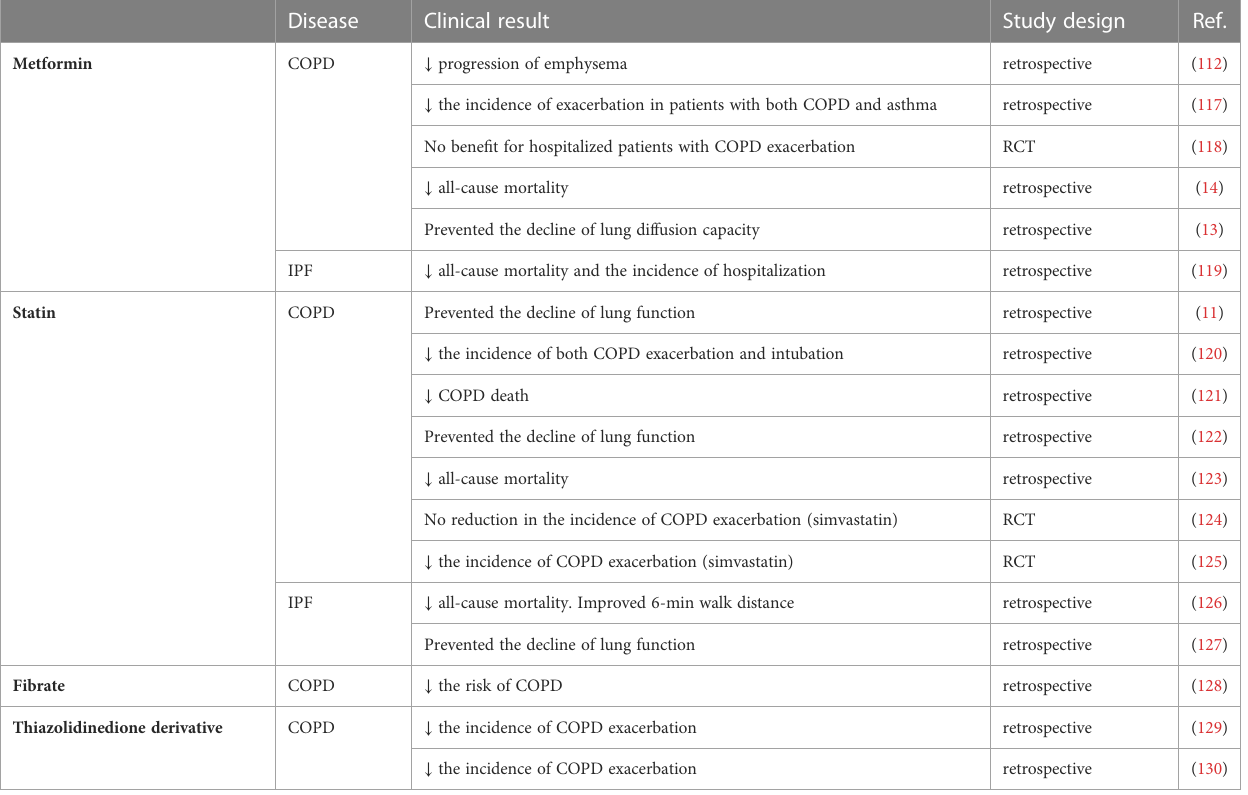
TABLE 1 Clinical outcomes of drugs against metabolic disease in COPD and IPF.